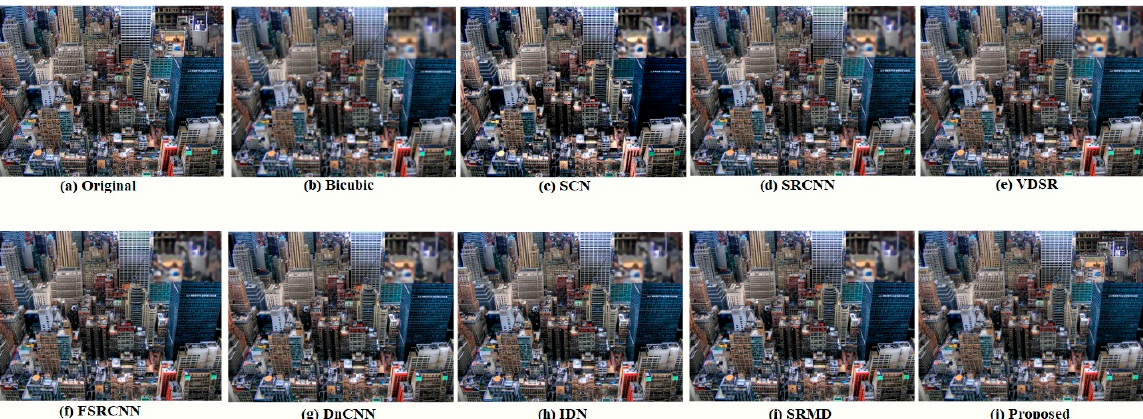
Figure 10. Visual comparison for the Urban04 image at the scale-up factor of 4.